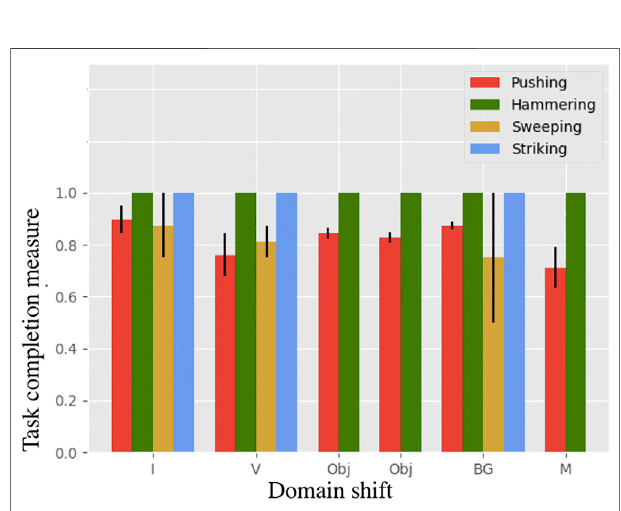
FIGURE 8 | Snapshot ofthe demonstration and execution of the corresponding optimal control sequences obtained for selected domain shifts from the real robot experiment (Results shown for action vectors extracted from pool5 layer of NN:UCF101 model).